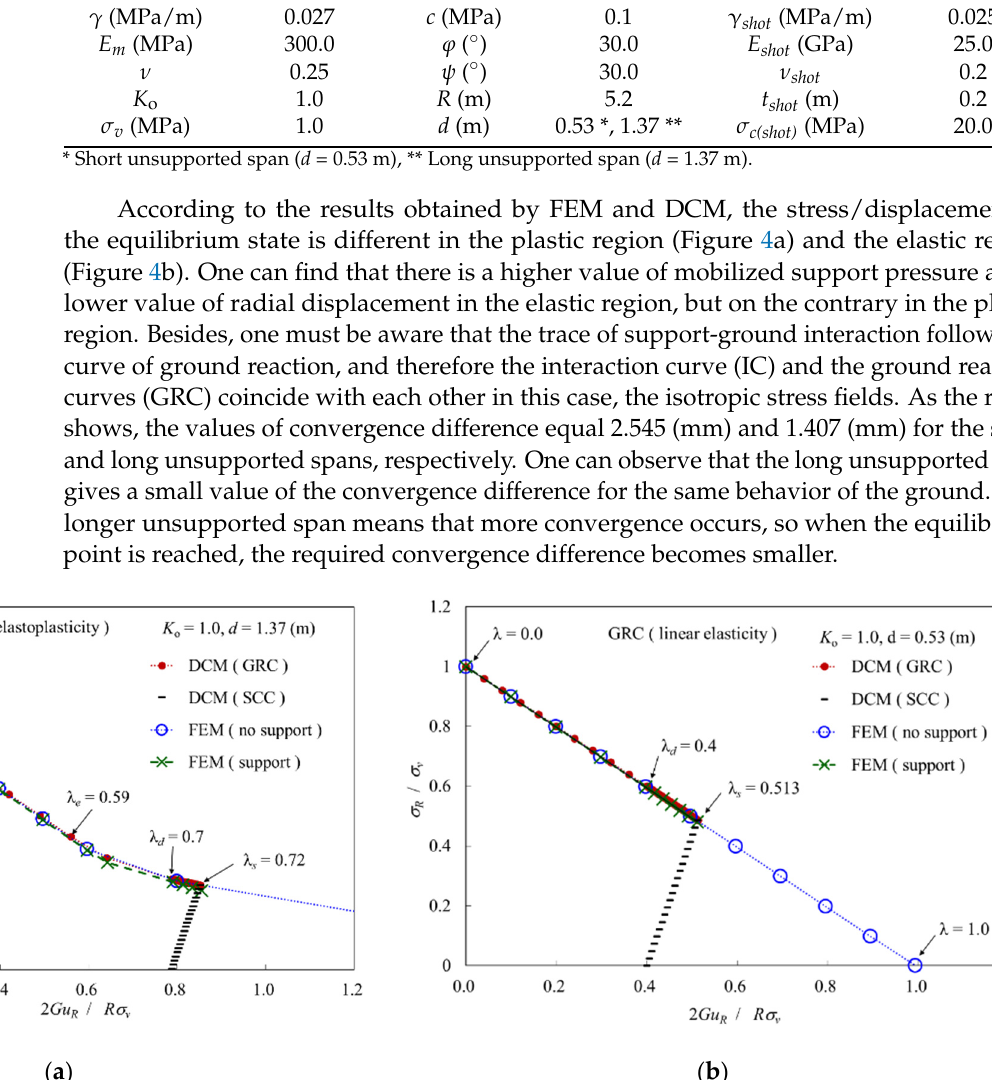
Table 1. Input data of the computation of DCM and FEM.